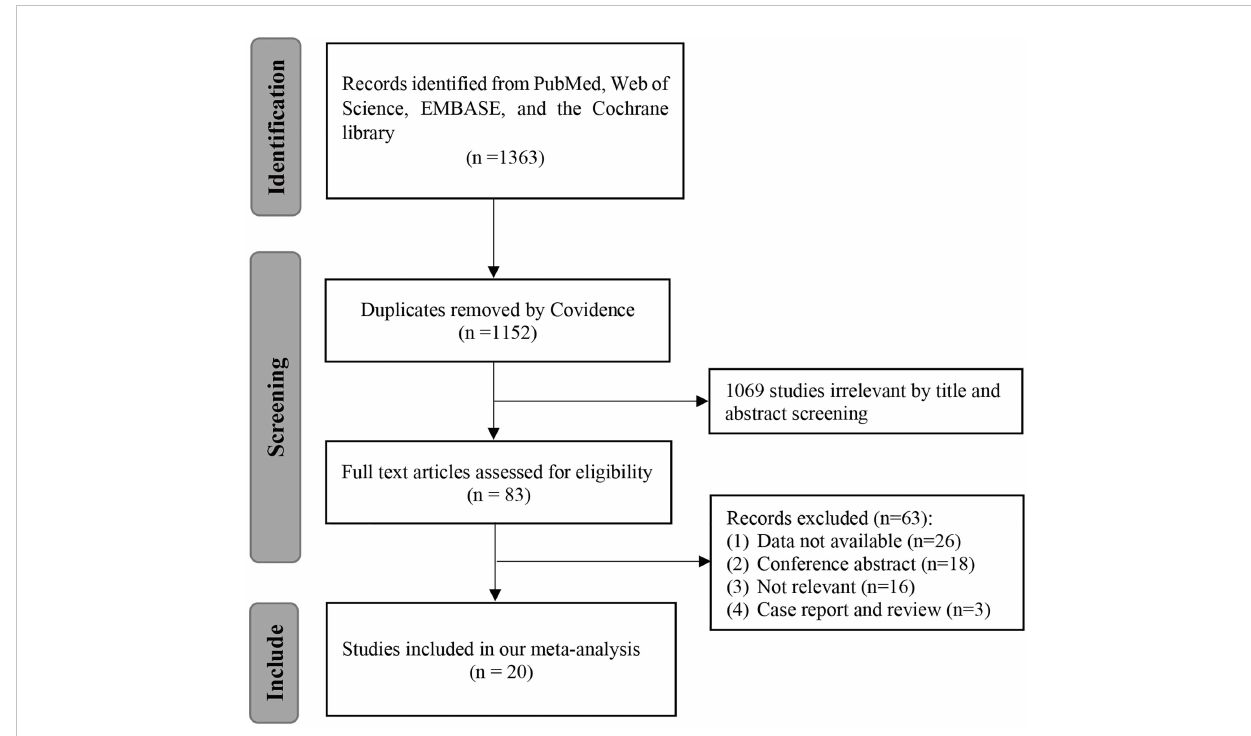
FIGURE 1 Flow diagram of study